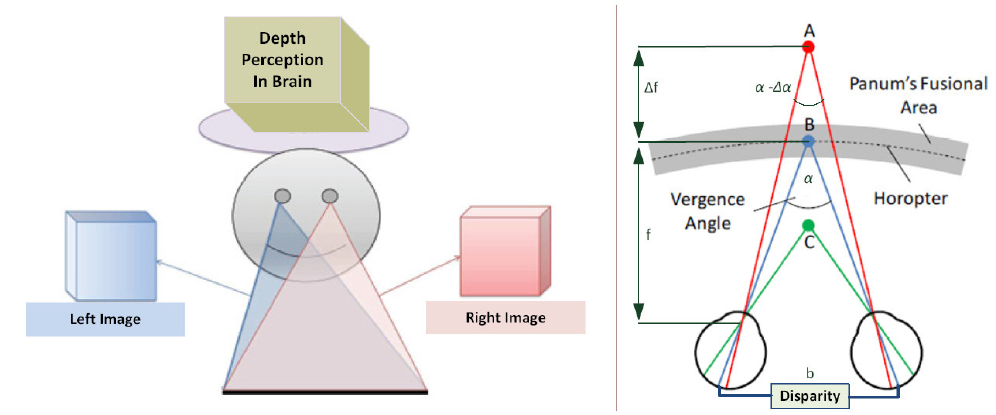
Figure 2. Binocular disparity and corresponding depth perception in the